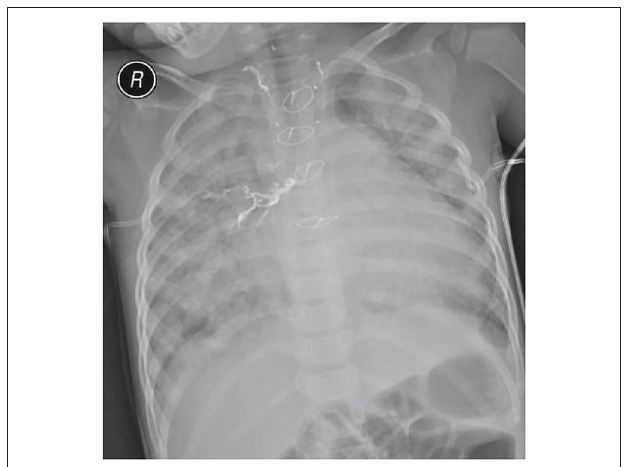
FIGURE 5 | Post-operative chest X-ray showing a representative image of severe pulmonary infection.